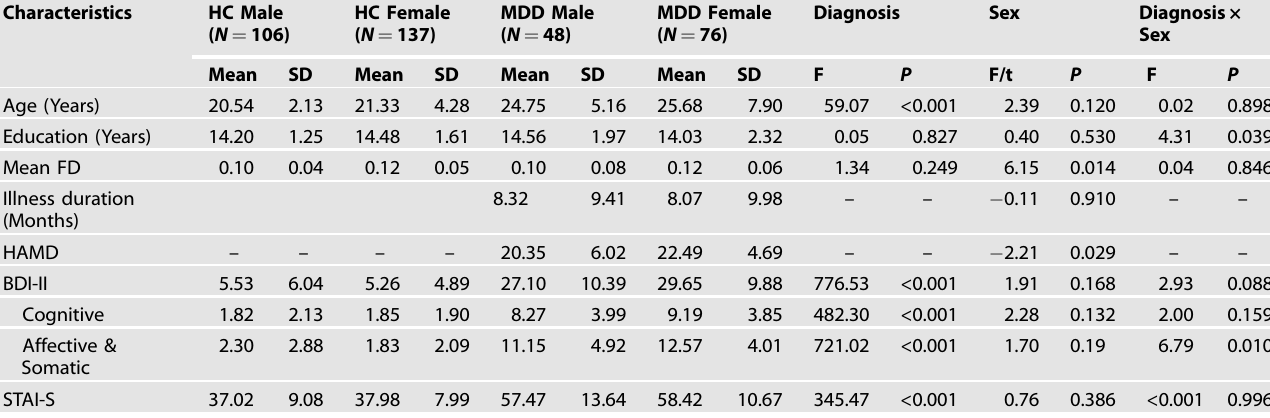
Table 1. Demographic and clinical characteristics of unmedicated fi rst-episode MDD and healthy controls.